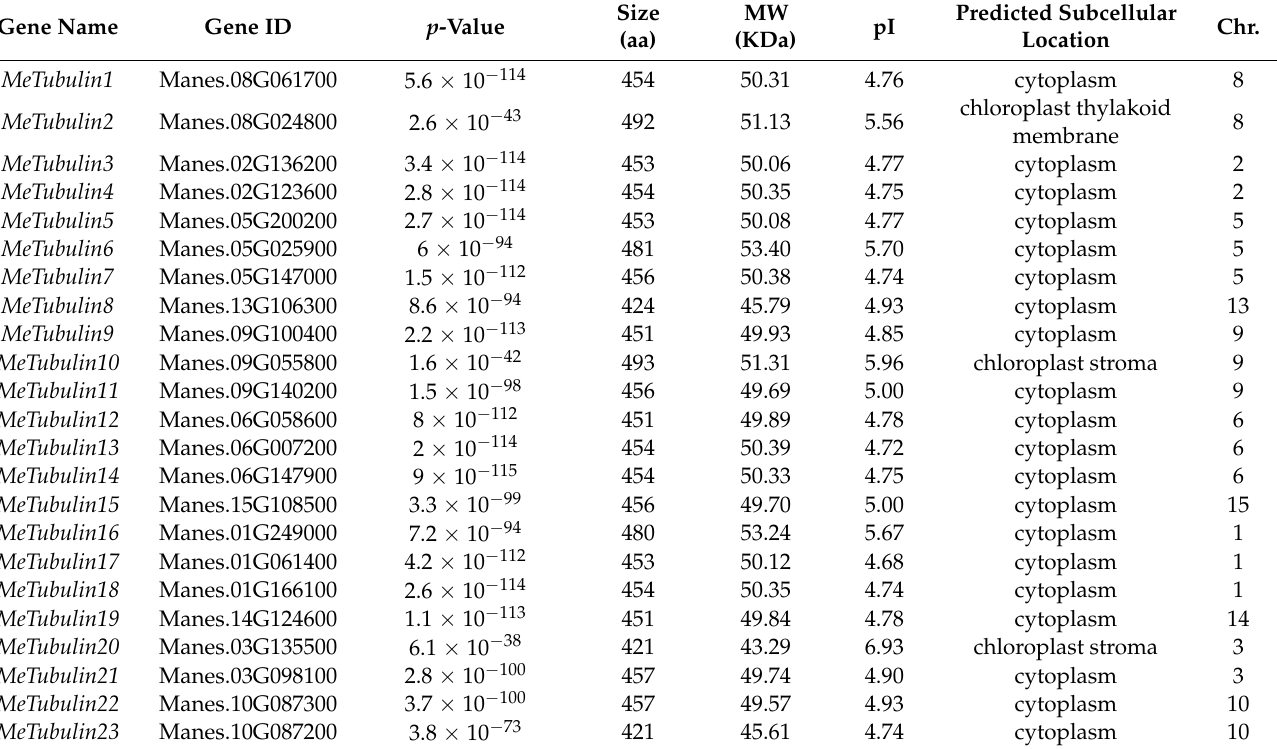
Table 1. Information of 23 MeTubulin genes and proteins